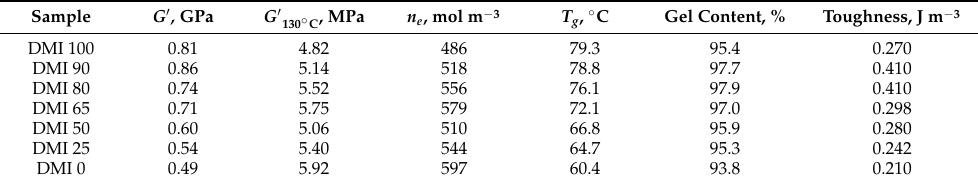
Table 2. The UPR storage modulus at 25 ◦ C ( G (cid:48) ) and 130 ◦ C ( G (cid:48) 130 ◦ C ), crosslink density ( n e ), T g , gel content and toughness.